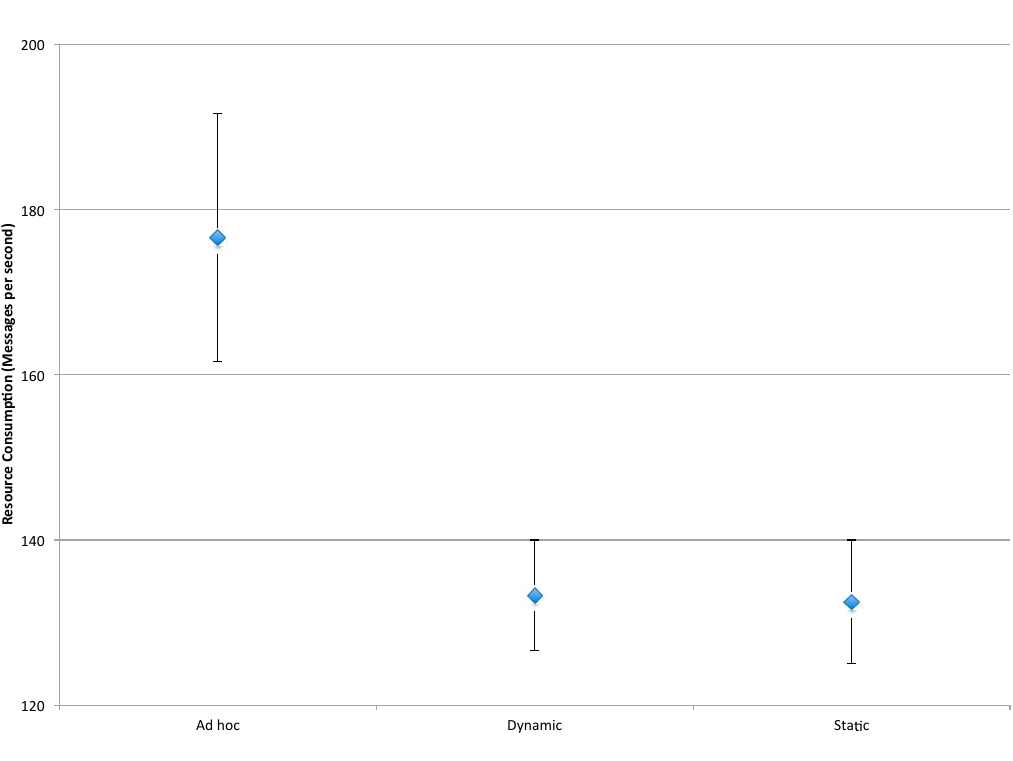
Figure 11. Interval plot for resource consumption. n = 160, ANOVA, 1 df , p < 0.05.